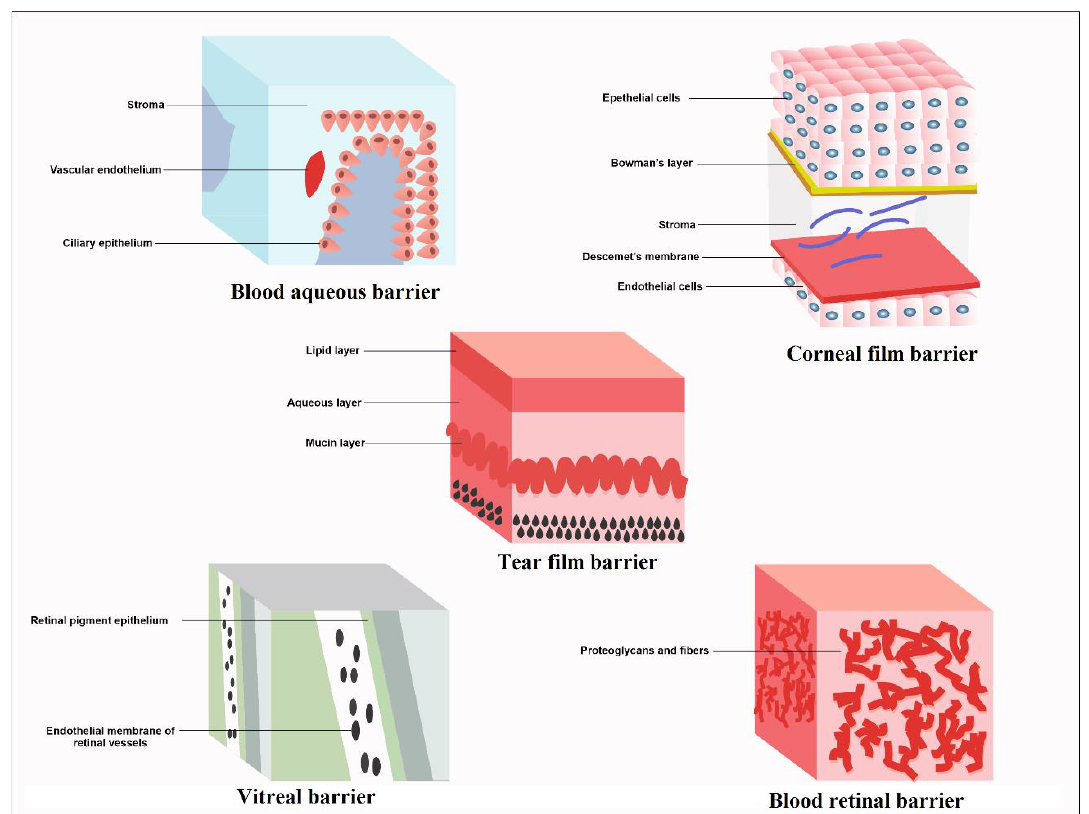
Figure 2. Schematic diagram depicting various ocular barriers for drug intake in the human eye.